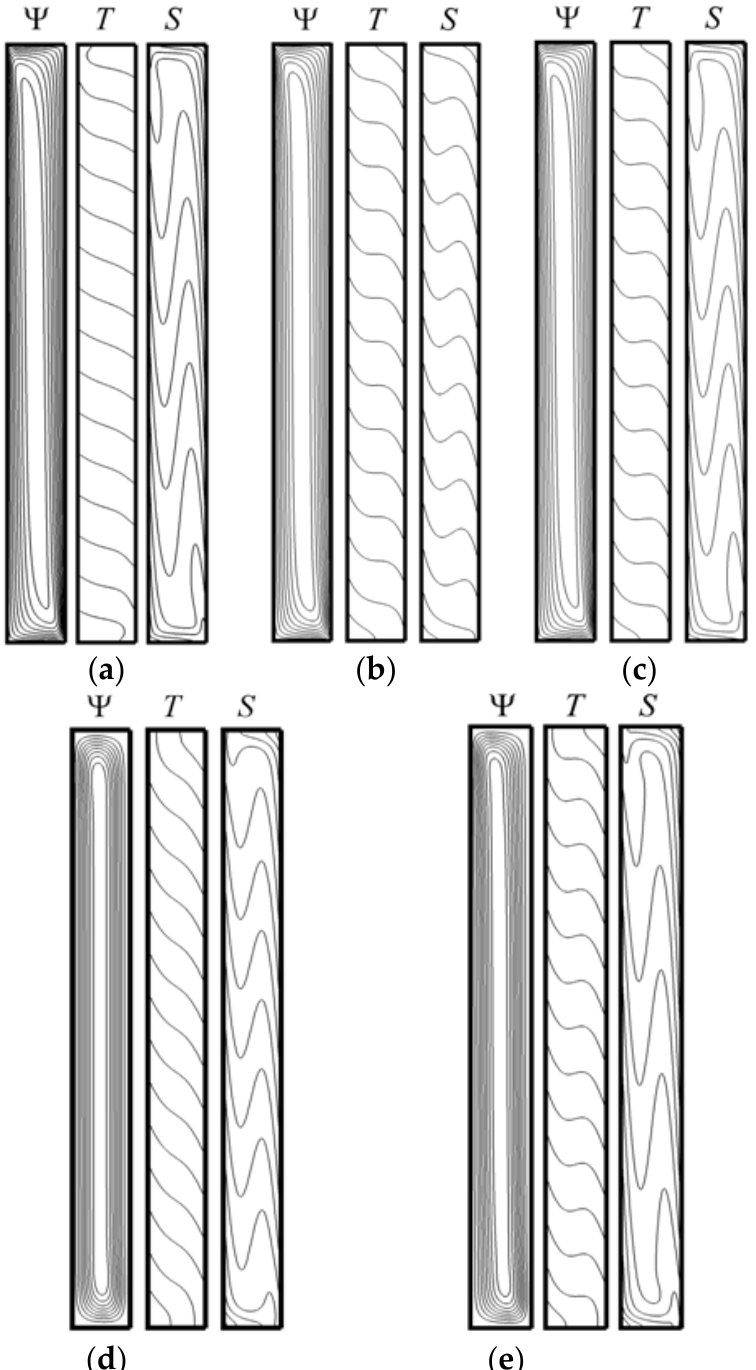
Figure 2. Contours of stream function (left), temperature (center), and concentration (right) for: A = 10, Le = 10, ε = 1: ( a ) Da e = 10 − 4 , R T = 200, S r = 0, D u = 0.8: Ψ 0 = 3.55, Nu = 3.20, and Sh = 5.28; ( b ) Da e = 10 − 4 , R T = 200, S r = 0.8, D u = 0: Ψ 0 = 2.79, Nu = 2.74, and Sh = 2.88; ( c ) Da e = 10 − 4 , R T = 200, S r = D u = 0.1: Ψ 0 = 3.45, Nu = 3.22, and Sh = 4.89; ( d ) Da e = 10 − 1 , and R T = 200, D u = S r = 0.1: Ψ 0 = 1.80, Nu = 1.64 and Sh = 2.91; and ( e ) Da e = 10 0 , R T = 10 4 , D u = S r = 0.1: Ψ 0 = 3.79, Nu = 2.43, and Sh =